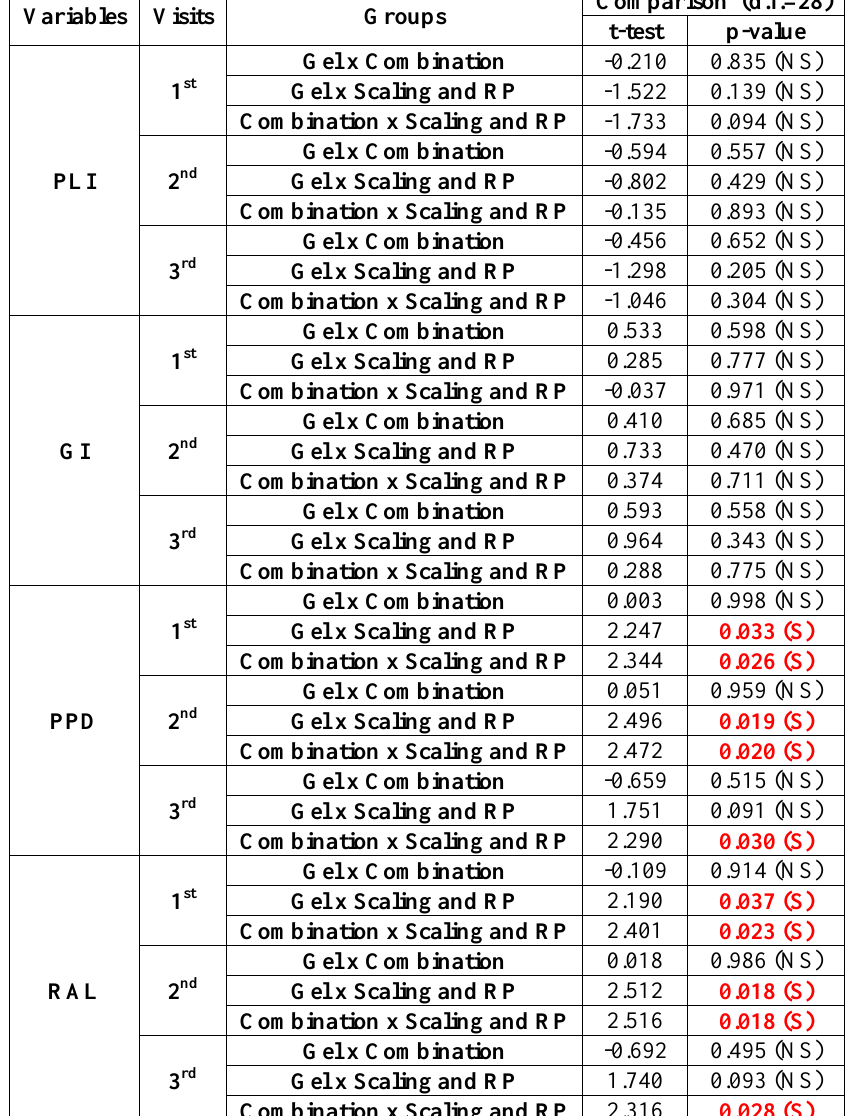
Table 3: Inter-groups Comparison between Each Two Groups of the Clinical Periodontal Parameters (PLI, GI, PPD and RAL) and the Significance of Differences by t-Test at Each Visit